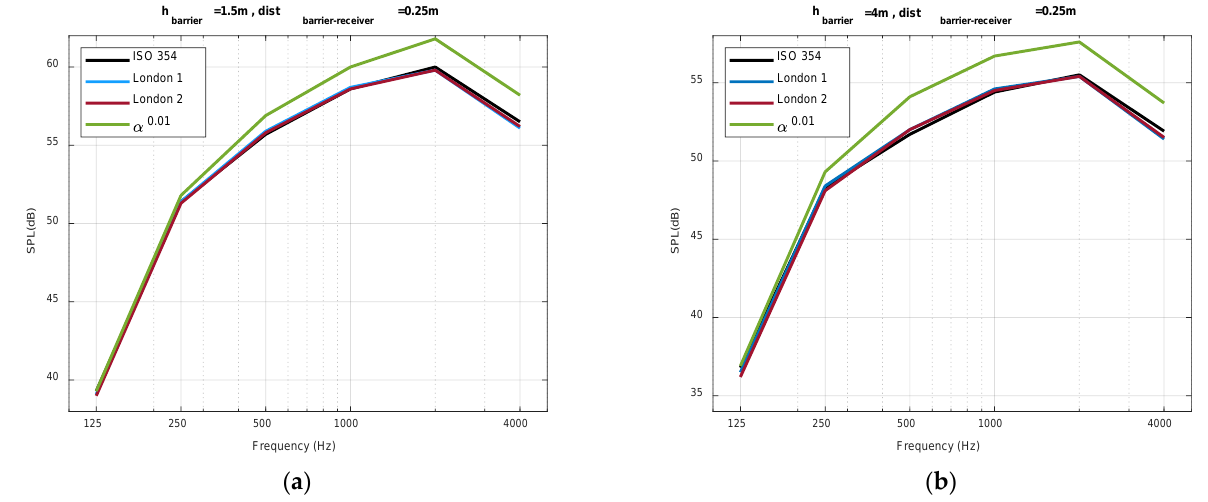
Figure 14. Sound pressure levels calculated using the CadnaA CNOSSOS-EU methodology, with the sound absorption obtained experimentally (ISO 354), through the London equations (London 1 and London 2) and reflective reference surface ( α 0.01), at 0.25 m from the noise barrier: ( a ) for the 1.5 m height barrier; and ( b ) for the 4 m height barrier.